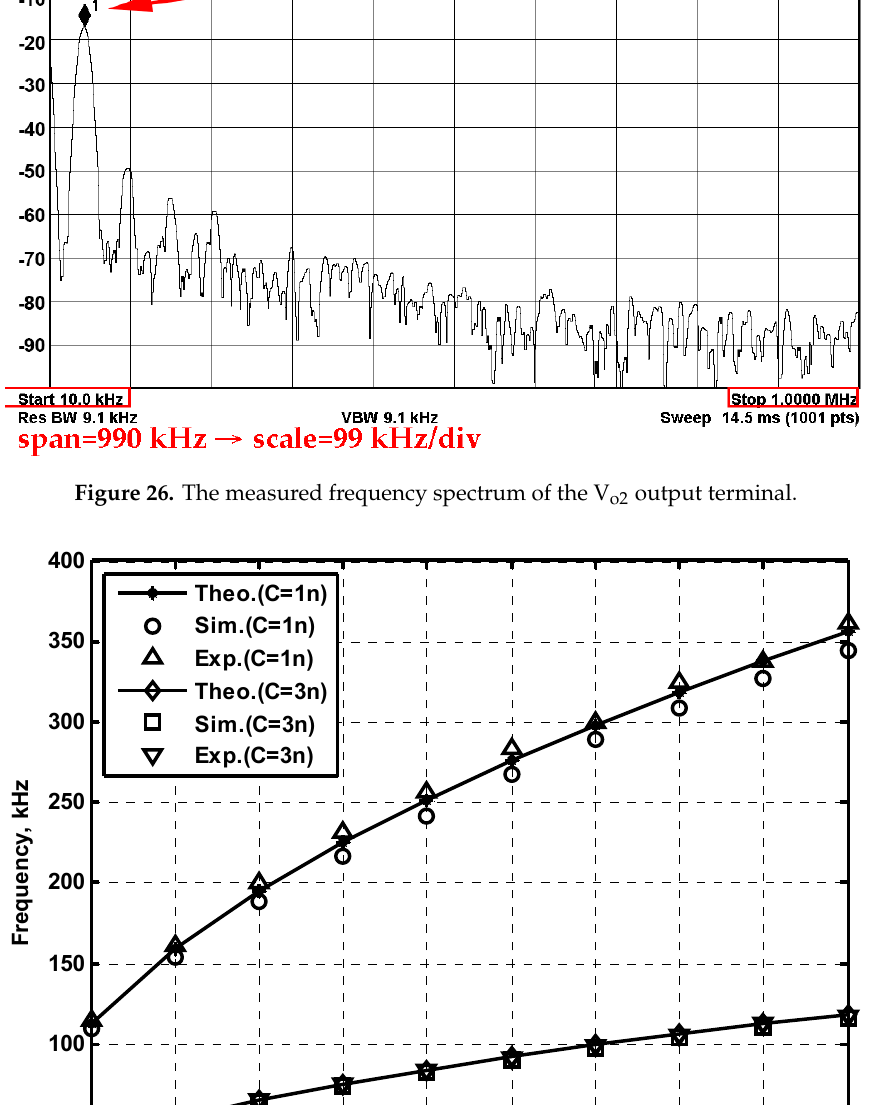
Figure 27. The frequency of oscillation (FO) theoretical, simulated and experimental results by varying